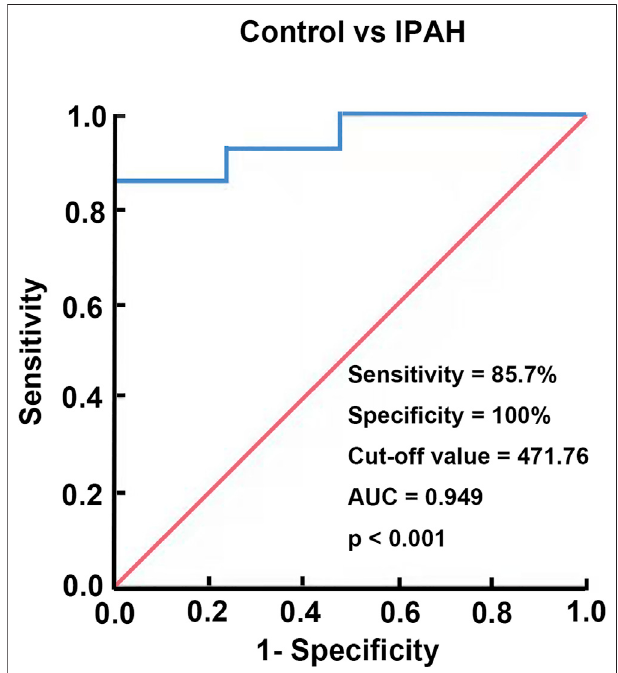
FIGURE 8 | Diagnostic value of chemerin expression in IPAH. A ROC curve of plasma chemerin for discriminating IPAH patients from healthy